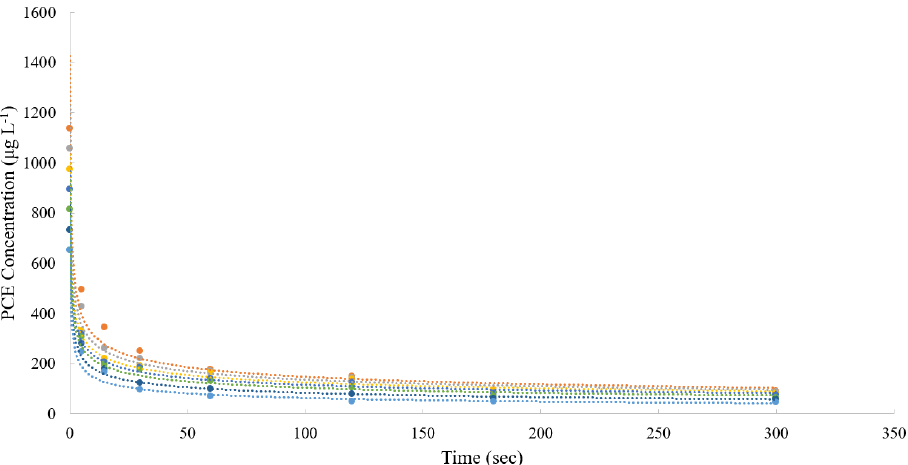
Figure 5. Adsorption experiment of different initial concentrations of PCE by activated carbon.